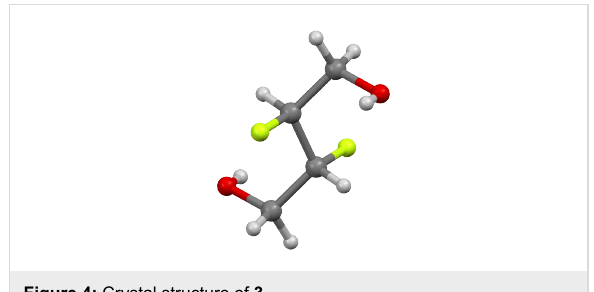
Figure 4: Crystal structure of 3 .